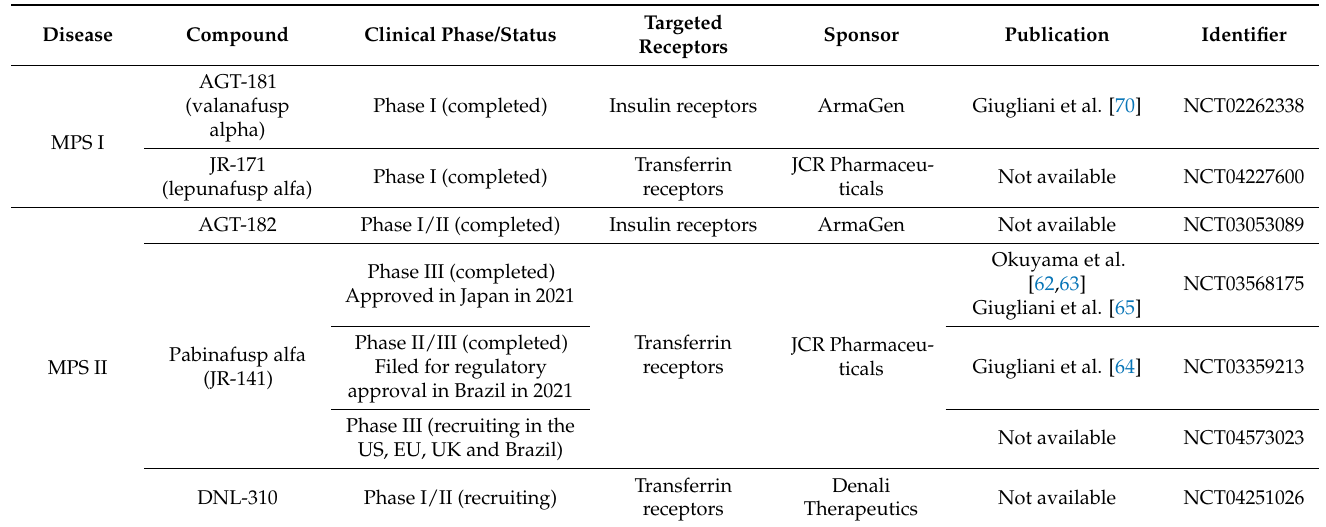
Table 1. Clinical trials of the new therapeutics for neuronopathic MPS that utilize receptor- mediated